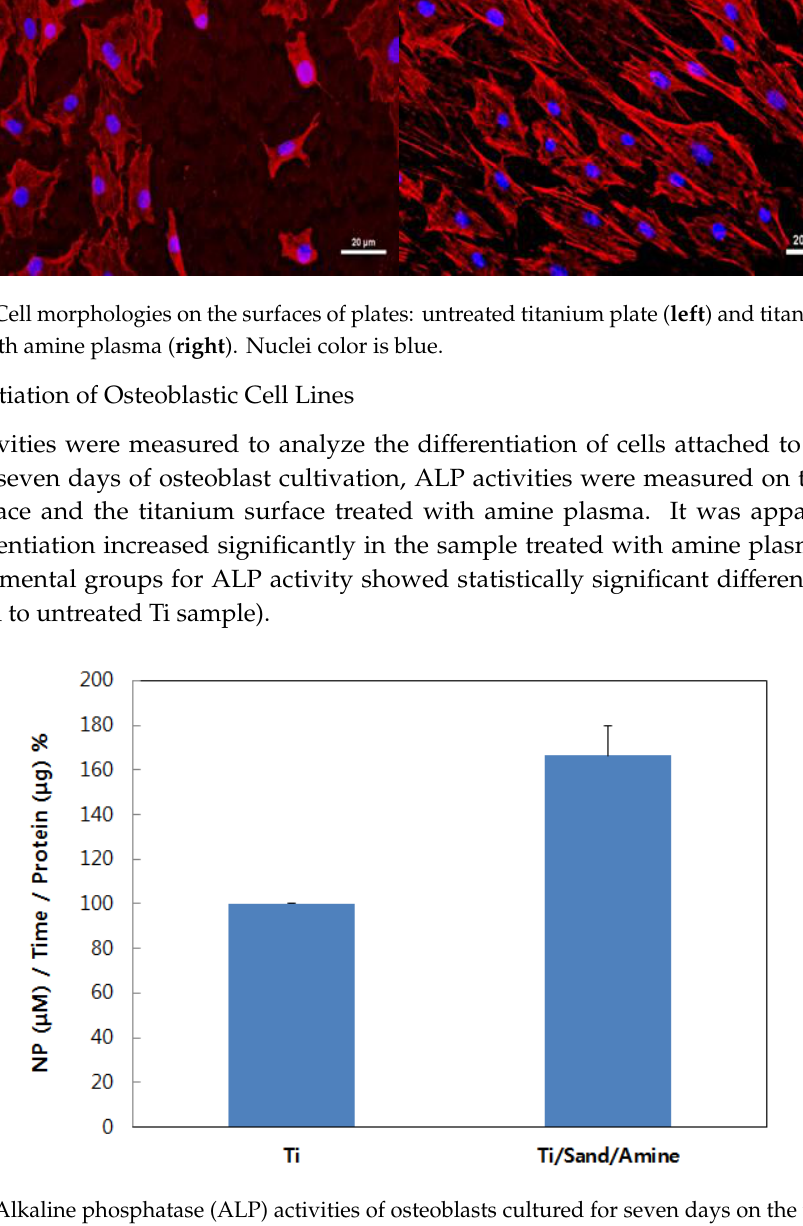
Figure 7. Untreated titanium surface and titanium surfaces treated with amine plasma. Proliferation rates of cultured osteoblasts on the surfaces after one, three, and five days.